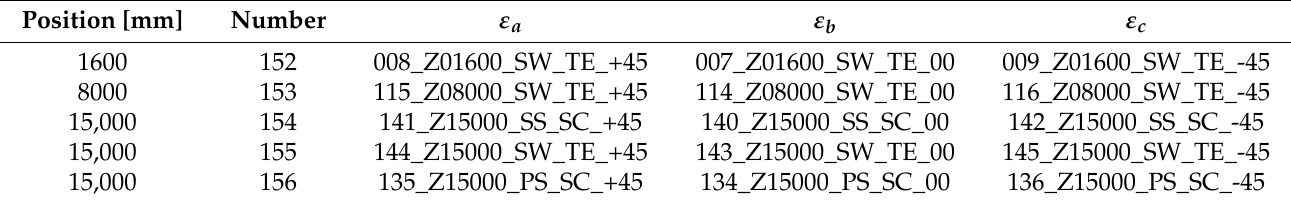
Table A2. List of sensor combinations to extract the shear strain based on Equation (2).